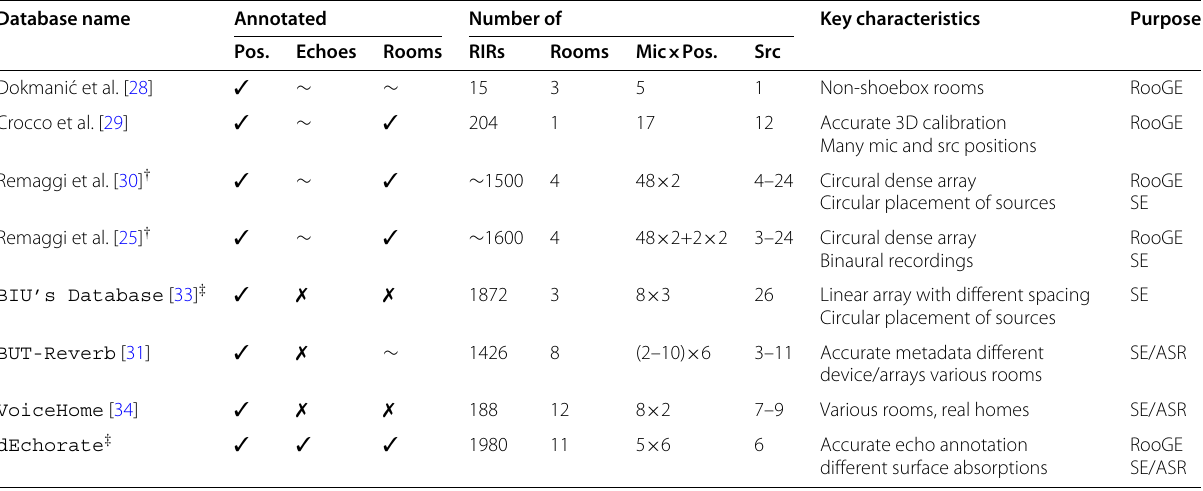
Table 1 Comparison between some existing RIR databases that account for early acoustic reflections. Receiver positions are indicated in terms of number of microphones per array times number of different positions of the array ( ∼ stands for partially available information). The read is invited to refer to [31, 32] for more complete list of existing RIR